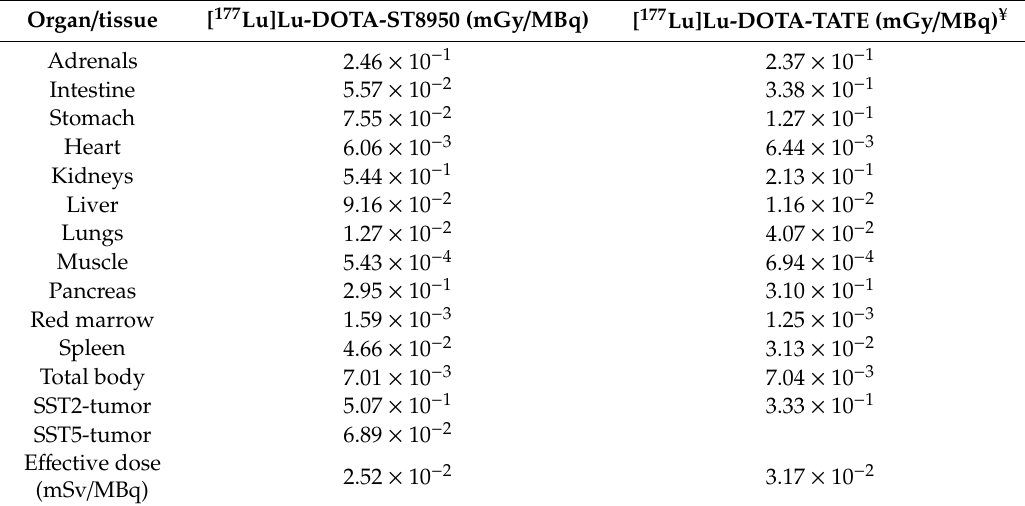
Table 6. Radiation dose estimation, extrapolated from mice to humans and expressed as Mean Absorbed Dose (mGy / MBq) for [ 177 Lu]Lu-DOTA-ST8950. [ 177 Lu]Lu-DOTA-TATE values estimated with the same methodology [32] are reported only for